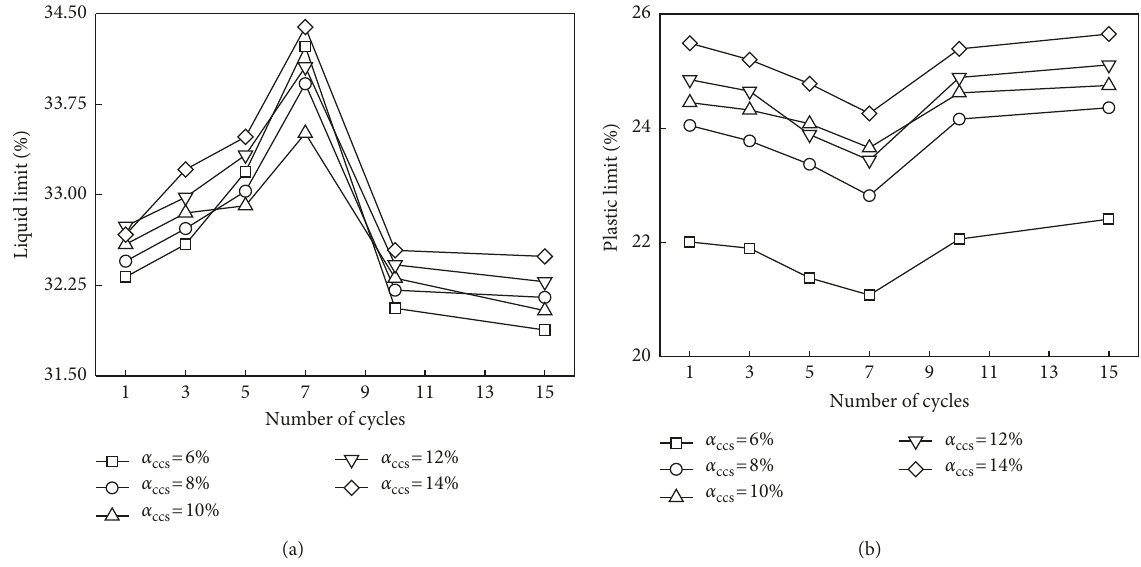
Figure 10: Evolutions of the Atterberg limits with the number of drying-wetting cycles: (a) liquid limit and (b) plastic